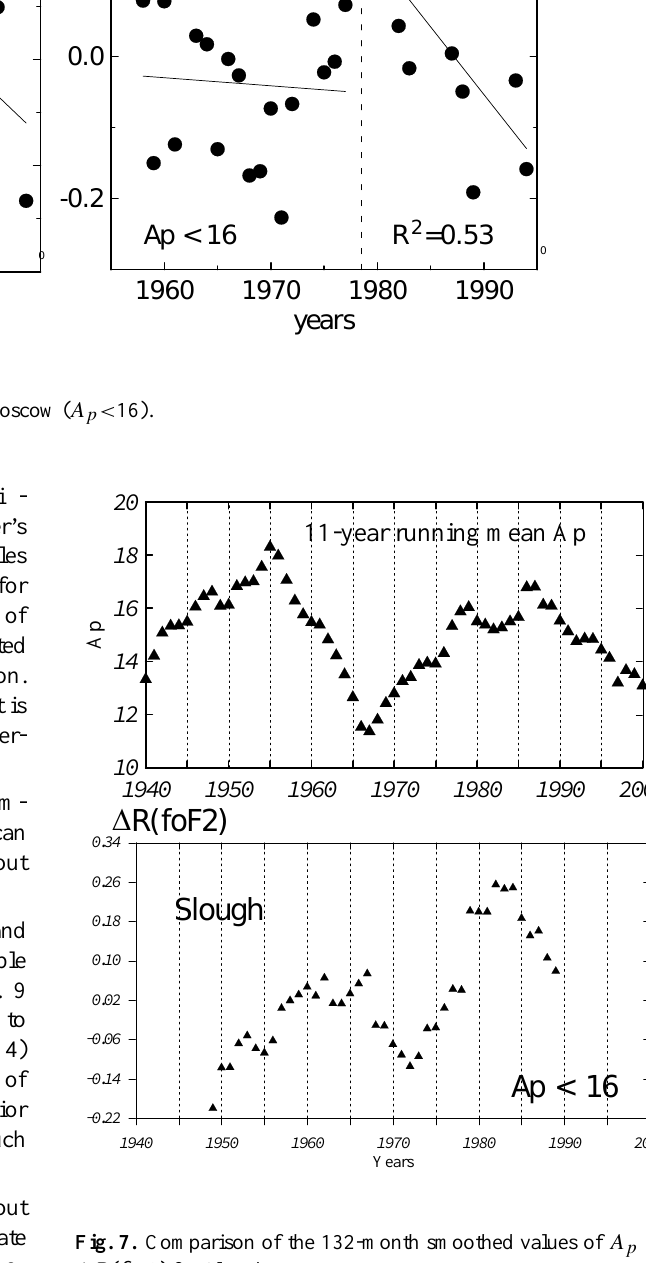
Fig. 7. Comparison of the 132-month smoothed values of A p and 1R ( fo F2) for